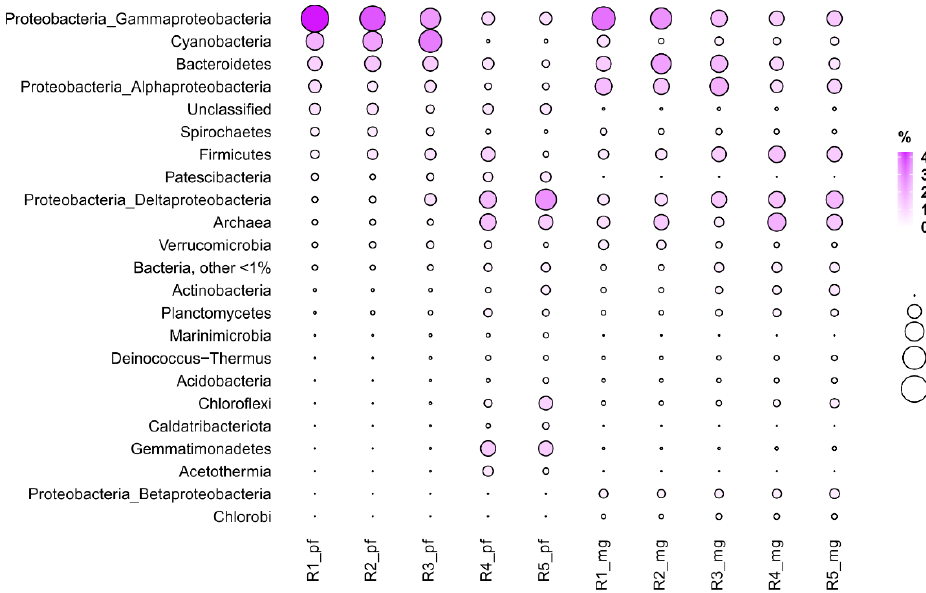
Figure 7. Abundant prokaryotic groups in Lake Solenoe. R_pf: Relative abundance of major taxa according to 16S rRNA reads in unassembled metagenomic datasets. R_mg: Relative abundance of the major taxa according to the analysis of all reads from the original dataset.